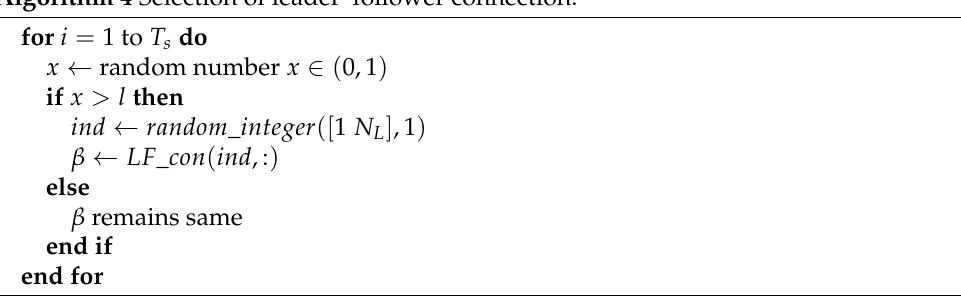
Algorithm 4 Selection of leader–follower